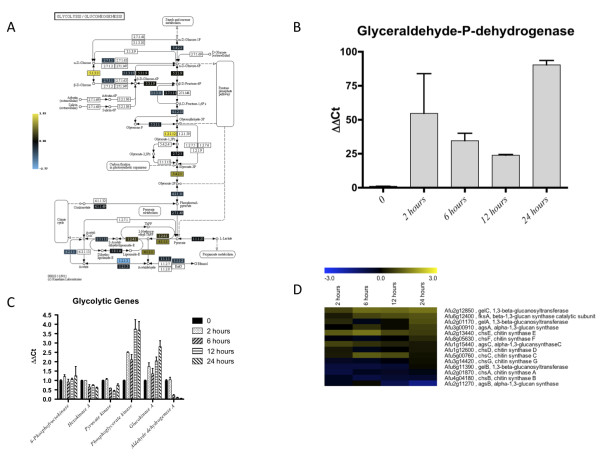
Hypoxia affects transcript levels of enzymes involved in glycolysis consistent with fermentation and cell wall components. A. KEGG pathway heat map representation of genes involved in glycolysis. Microarray datasets include three biological and two technical replicates. Microarrays compare wild type Aspergillus fumigatus strain CBS144.89 at the indicated times after exposure to hypoxic conditions to the time point immediately prior to hypoxia exposure (0 hours) using the median value from all replicates. Yellow indicates transcript level is higher in hypoxia. Scale indicates degree of change. B. RT-PCR of Glyceraldehyde-3-phosphate-dehydrogenase supported the observation that this was one of the most abundant hypoxia responsive transcripts in the microarray, as well as in the proteomics analysis. C. Six genes in the glycolysis pathway in Aspergillus fumigatus. Transcript levels of 6-phosophofructokinase, hexokinase A and pyruvate kinase were not dramatically altered. Transcript levels of phosphoglycerate kinase and glucokinase A are 2 to 4-fold increased in response to hypoxia. Aldehyde dehydrogense A transcript level was significantly decreased at 6, 12 and 24 hours. All RT-PCRs were performed on BioRad MyIQ real-time PCR detection system with IQ SYBR green supermix. The ΔΔCt method was used to combine all biological and technical replicates for each transcript, using β-tubulin as the housekeeping gene for comparison. D. Heat map representation of cell wall component transcripts that were compiled from literature [36]. Both microarray datasets include three biological and two technical replicates, and compare wild type Aspergillus fumigatus strain CBS144.89 at the indicated times after exposure to hypoxic conditions to the time point immediately prior to hypoxia exposure (0 hours) using the median value from all replicates. Yellow indicates transcript level is higher in hypoxia.